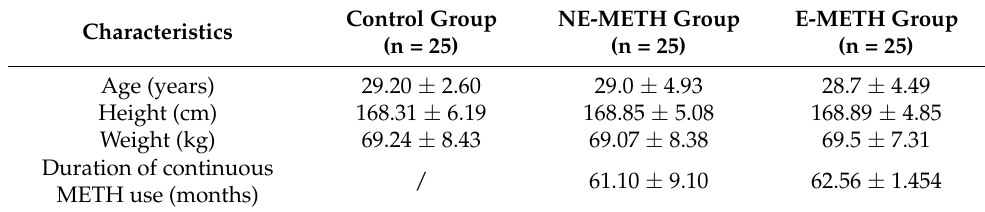
Table 7. Basic information of the experimental